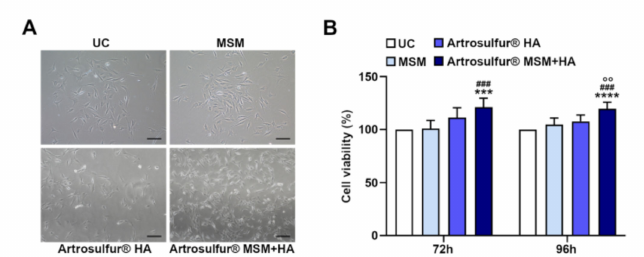
Figure 1. Cell morphology and proliferation (MTT (3-[4,5-dimethyl-thiazol-2-yl-]-2,5-diphenyl tetrazolium bromide) assay) in tendon-derived cells that were treated with methylsulfonylmethane (MSM) (0.3% w / v ), Artrosulfur ® hyaluronic acid (HA) (1000 µ g / mL), and Artrosulfur ® MSM + HA (0.3% w / v + 1000 µ g / mL) for 72 h and 96 h: ( A ) After 96 h of treatment, cell morphology was observed by optical microscopy. Elongated cells are viable and adherent, while rounded floating cells are detached. UC: control untreated cells. Magnification, × 100. ( B ) The graph represents OD (optical density) values in control and treated samples. Data shown are the means ( ± SD) of three independent experiments. UC: control untreated cells. *** p ≤ 0.001 and **** p ≤ 0.0001 vs. UC; ### p ≤ 0.001 vs. MSM; and ◦◦ p ≤ 0.01 vs.